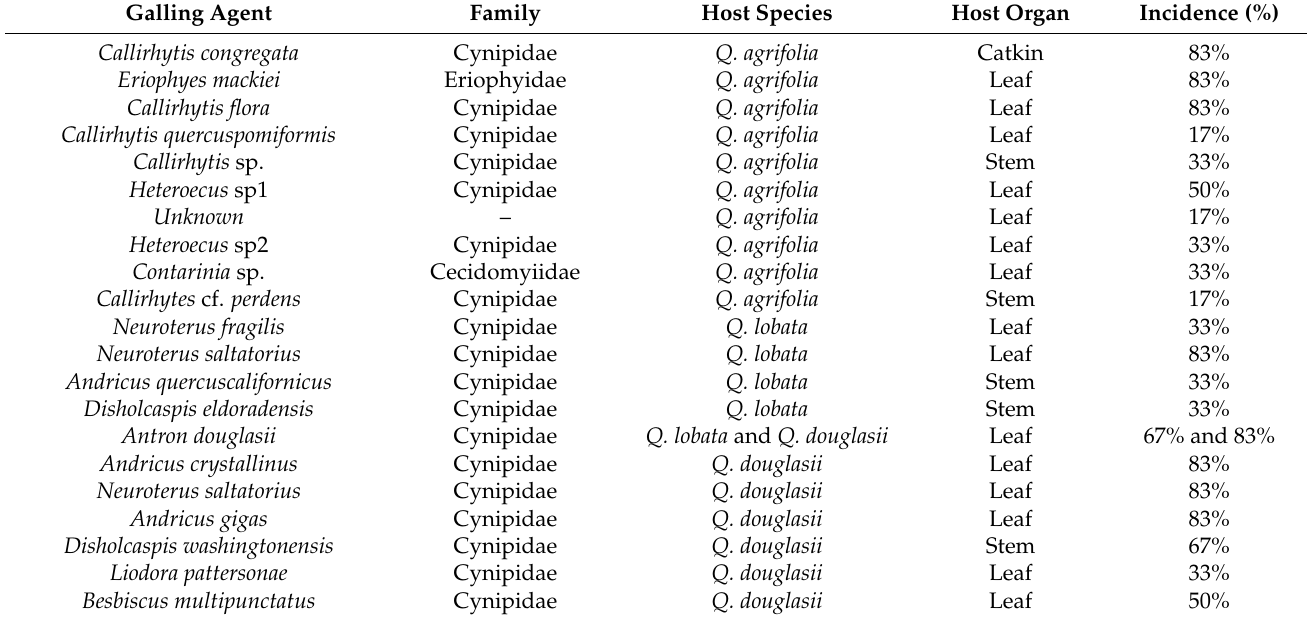
Table 1. Galling agents, taxonomic family, host species, host organ and incidence (percentage of trees affected) for the three main Quercus species at Jasper Ridge Biological Preserve (Northern California).